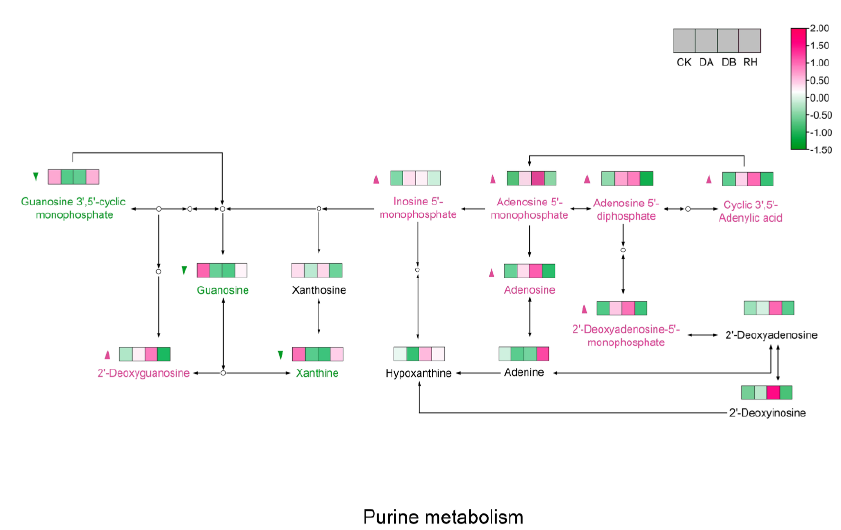
Figure 8. Comparison of metabolites involved in purine metabolism among the control (CK), 15-day drought treatment (DA), 30-day drought treatment (DB), and rehydration (RH) groups.